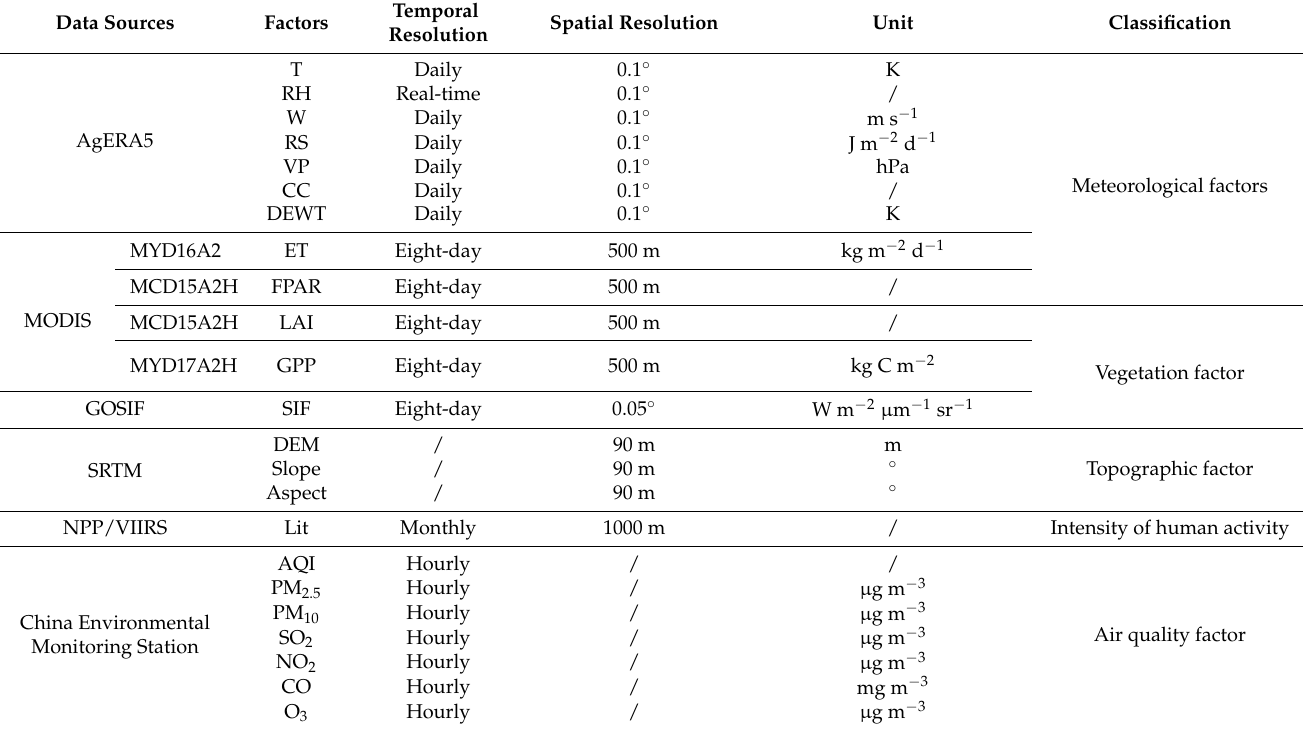
Table 1. Data overview of the driving factors on NAI